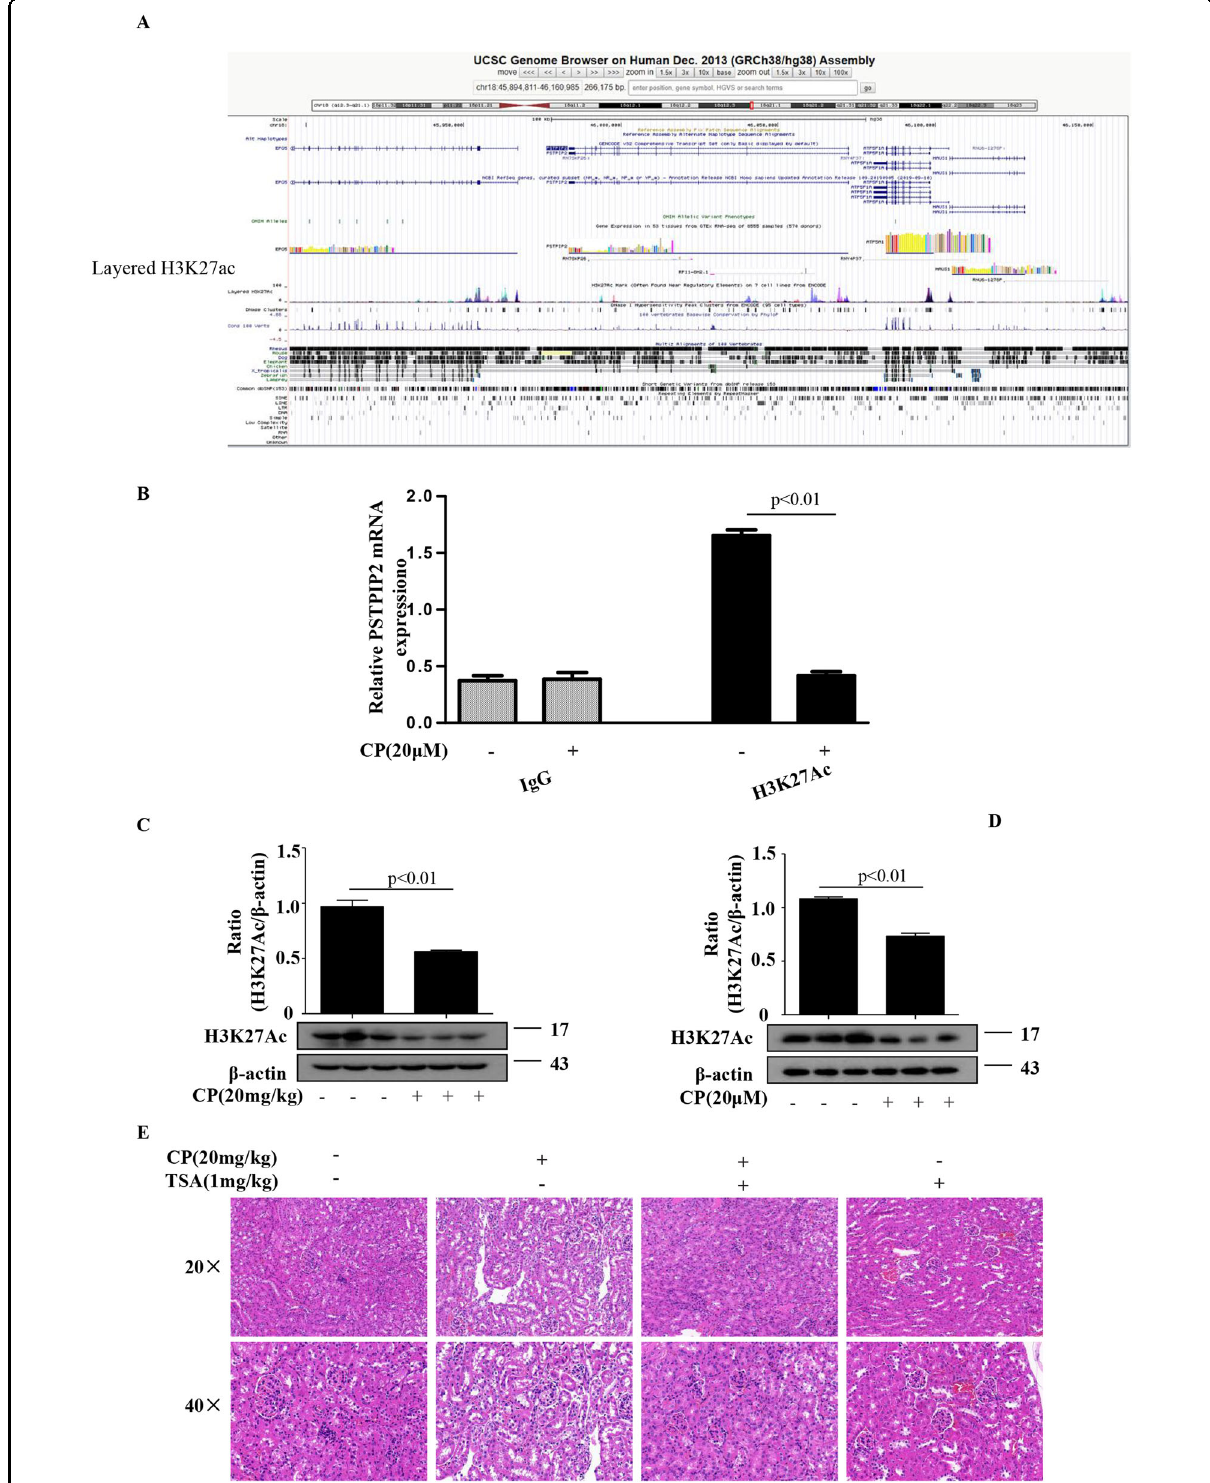
Fig. 6 HDAC inhibitor upregulated PSTPIP2 expression in vivo and in vitro. a The annotation information of H3K27Ac locus from the UCSC genome browser. b Chromatin immunoprecipitation assay of acetylated histone in the PSTPIP2 promoter region. c Protein expression of H3K27Ac in kidney tissue detected by western blot. d Protein expression of H3K27Ac in CP-treated HK-2 cells detected by western blot. e Representative images of H&E staining of the kidney sections with CP-induced acute kidney injury (AKI) in mice treated with TSA. Scale bars, 50 μ M and 20 μ M; magni fi cation, 20× and 40×. Similar results were obtained in 3 independent experiments with 10 mice per group or in triplicate culture